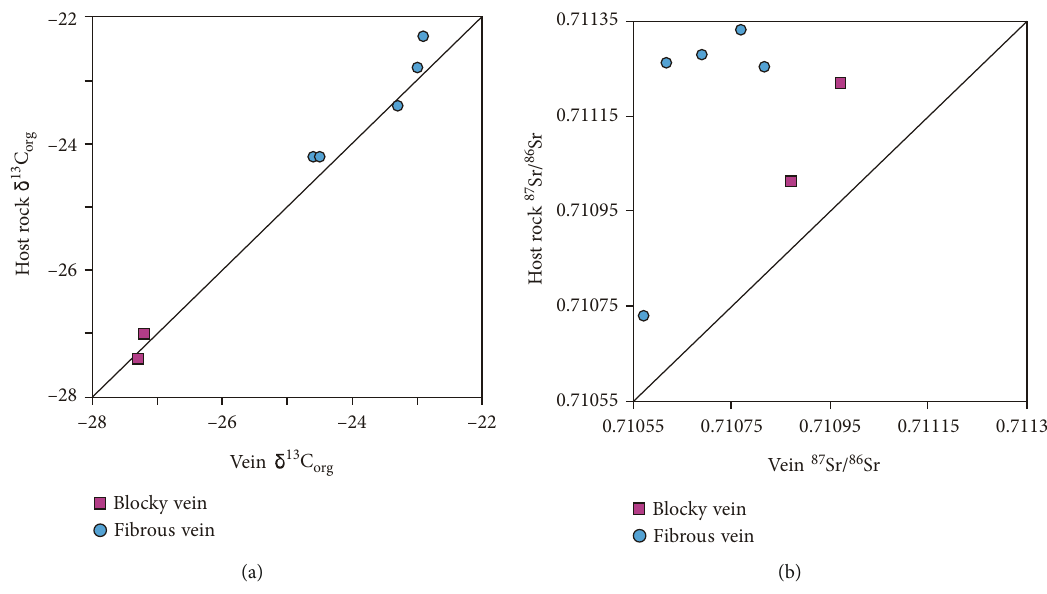
Figure 13: Organic carbon (a) and strontium (b) isotopes of calcite veins and host